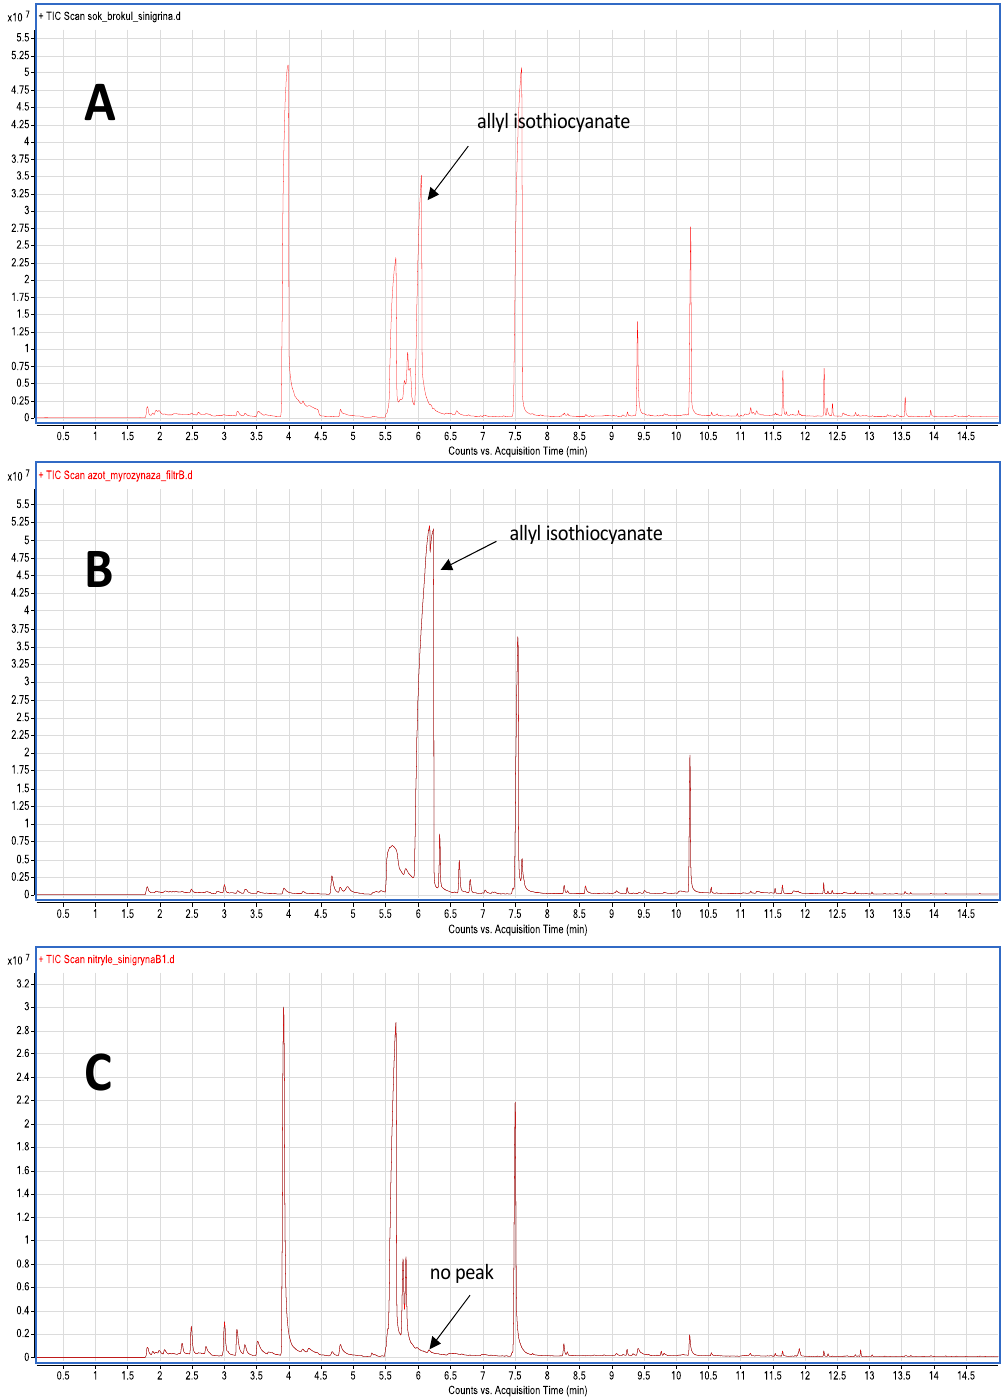
Figure 4. Chromatograms from enzyme activity assay experiment, presenting the amount of sinigrin degradation products-allyl isothiocyanate. ( A ) the broccoli extract before proteins separation with sinigrin addition, ( B ) extract after separation (the upper layer, with myrosinase) with sinigrin addition, ( C ) extract after separation (containing nitrile-specifier proteins) with sinigrin